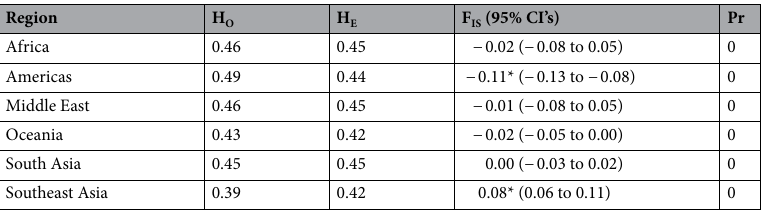
Table 2. Genetic diversity for 208 M. indica accessions across six geographic regions using 272 SNPs. H O , observed heterozygosity; H E , expected heterozygosity; F IS , inbreeding co-efficient with 95% confidence intervals, where *CI’s do not overlap with 0; Pr, the number of private alleles.